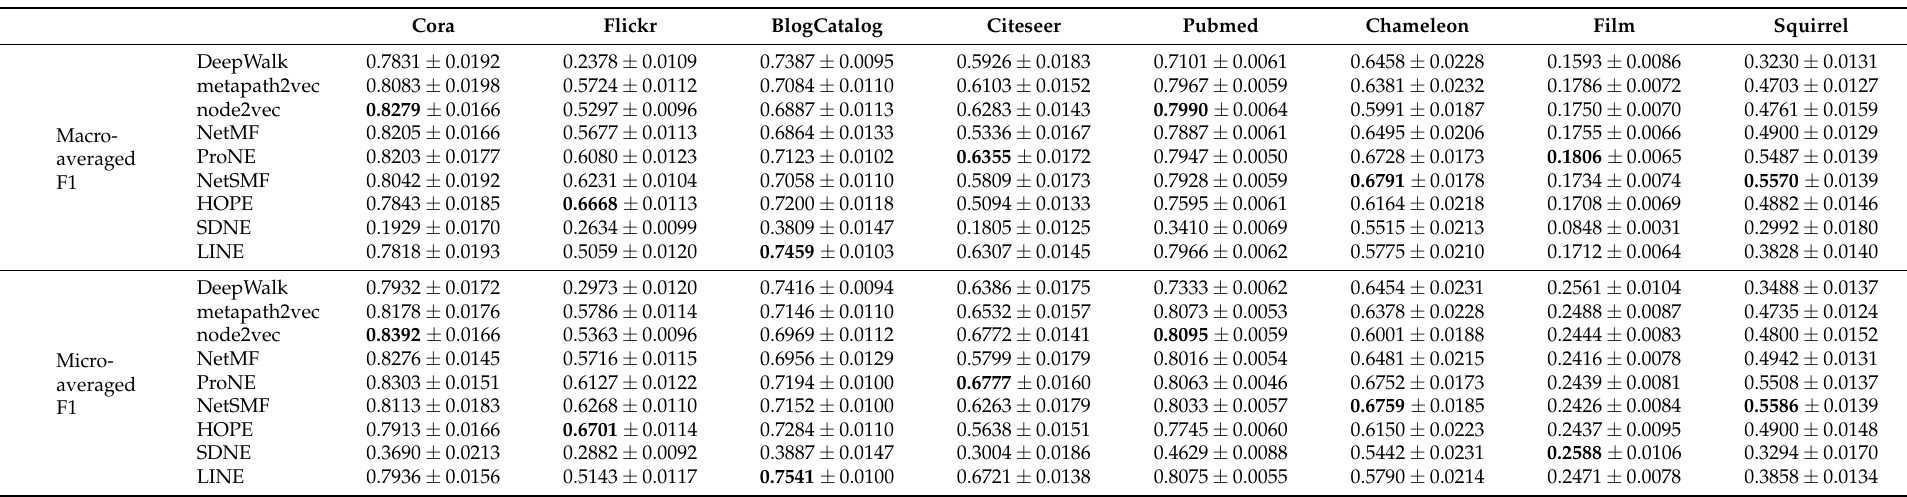
Table 5. Results in Task 3, i.e., classification fined-tuned via link prediction, on pure networks, using random search to tune hyperparameters. Best results are shown in